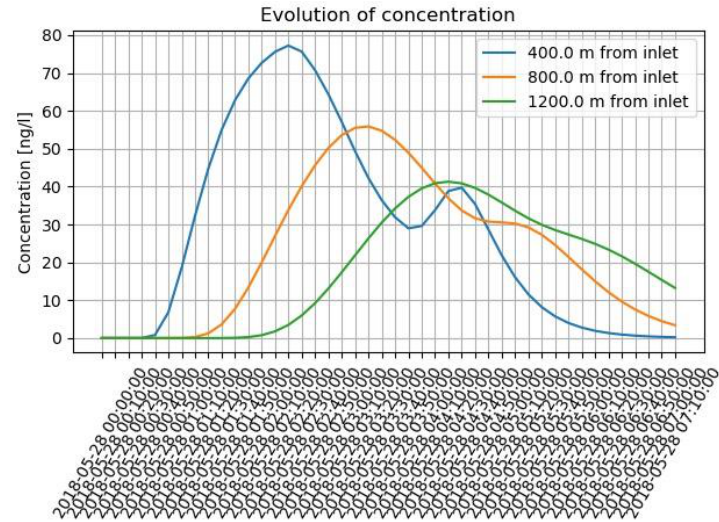
Figure 11. Simulated concentration at x = 400 m, x = 800 m, and x = 1200 m from the inlet point with 10 min time step length.